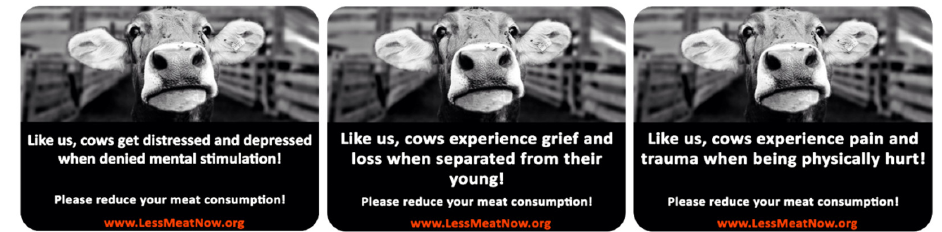
Figure 3. The three anthropomorphic stickers (Sticker 1: Negative intelligence anthropomorphism, sticker 2: Negative pro-social anthropomorphism, sticker 3: Pain anthropomorphism).